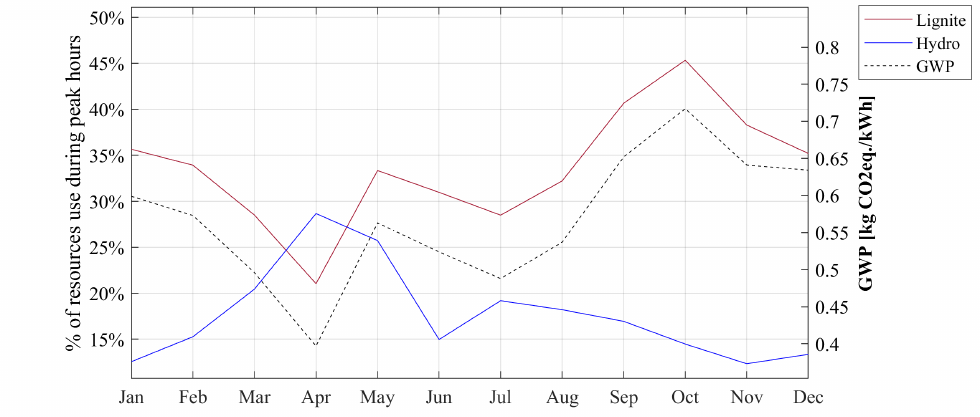
Figure 4. Percentage use of resources throughout the year compared with monthly GWP in Bulgaria, both related to peak